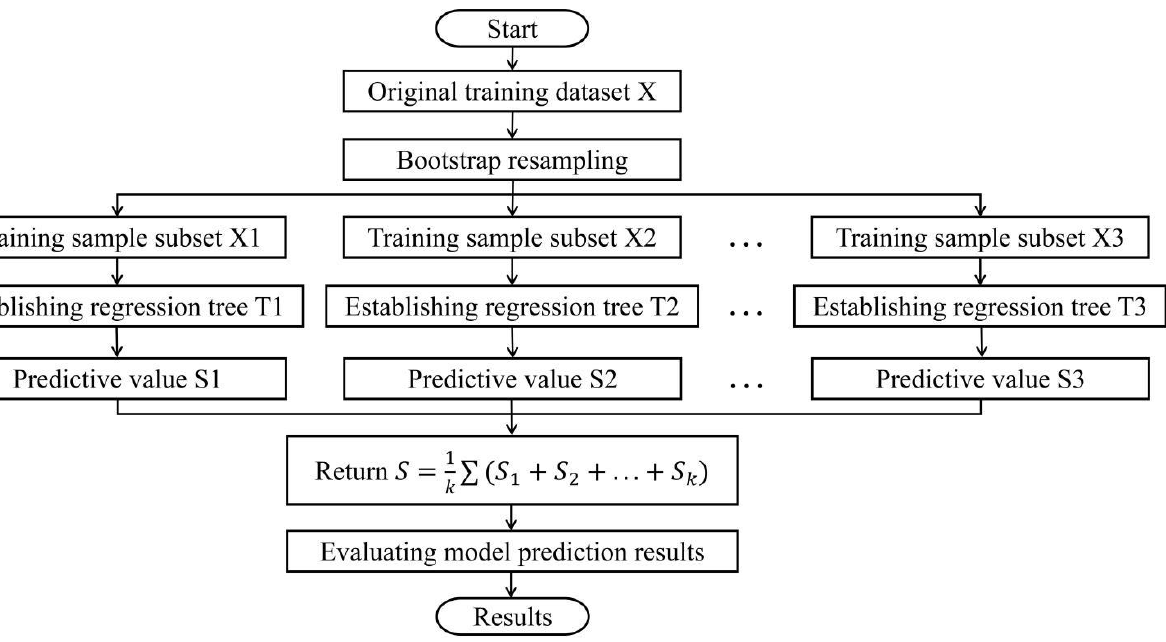
Figure 2. Flowchart of random forest algorithm.